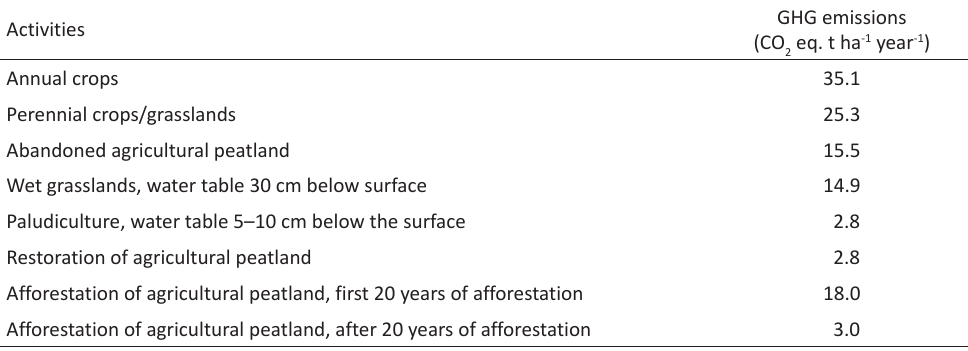
Table 2. The GHG emission intensities for the different types of activities on